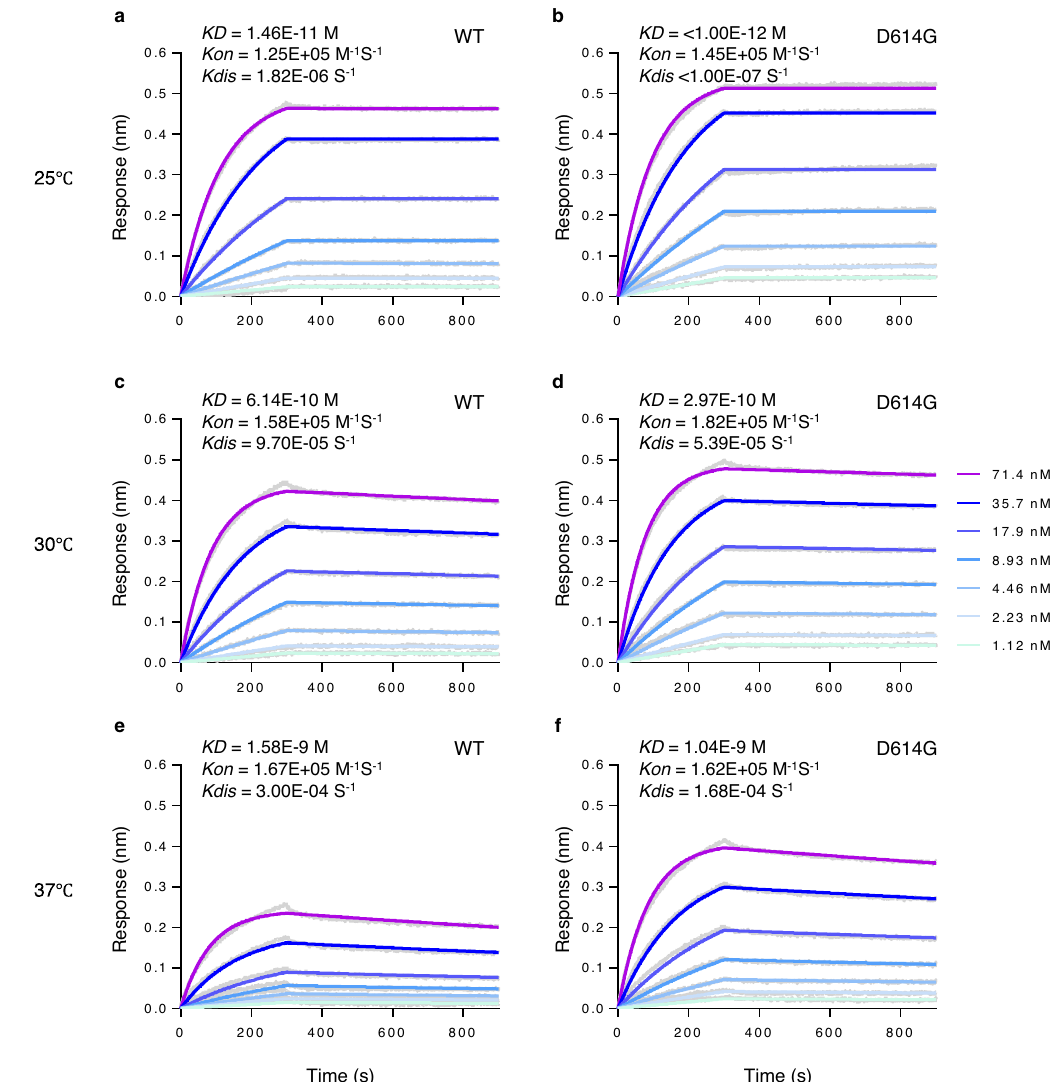
Fig. 4 SARS2-S D614G protein binds ACE2 with higher af fi nity than WT S protein. Binding af fi nity between dimeric ACE2 and trimeric SARS2-S WT ( a , c , and e ) or D614G variant ( b , d , and f ) (two-fold serially diluted from 71.4 nM to 1.12 nM) was evaluated at 25 °C ( a and b ), 30 °C ( c and d ), or 37 °C ( e and f ) using Octet RED96 instrument. The association rate constants ( K on ) and dissociation rate constants ( K dis ) were determined by global fi tting of the experimental data using a 1:1 binding model. Equilibrium dissociation constants ( K D ) were obtained from K dis ∕ K on . Data shown are representative sensorgrams from two independent experiments at 25/37°C and from three independent experiments at 30°C using different protein preparations. The difference in K D and K dis at 30°C was statistically signi fi cant ( p = 0.0042 and 0.0129, respectively) by a two-tailed unpaired Student ’ s t -test, as shown in Supplementary Fig. 5. Source data are provided as a Source Data fi